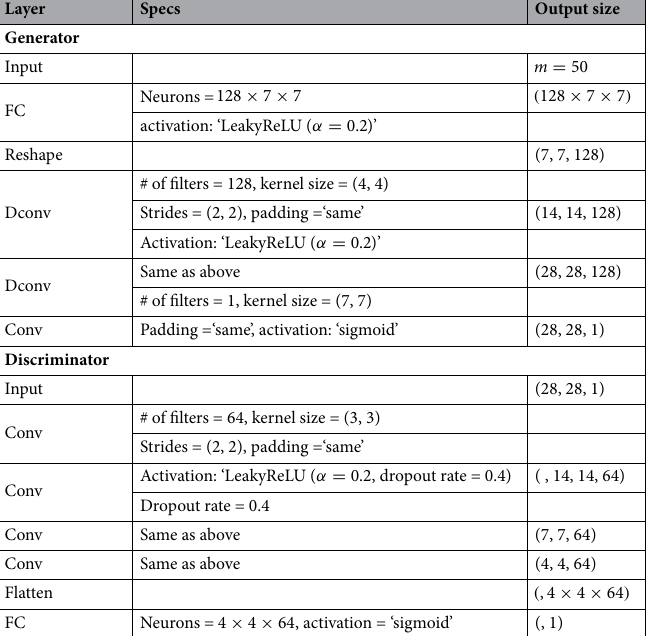
Table 1. Neural Networks of the GAN in Fig. 2. FC fully-connected layer, Dconv de-convolutional layer, Conv convolutional